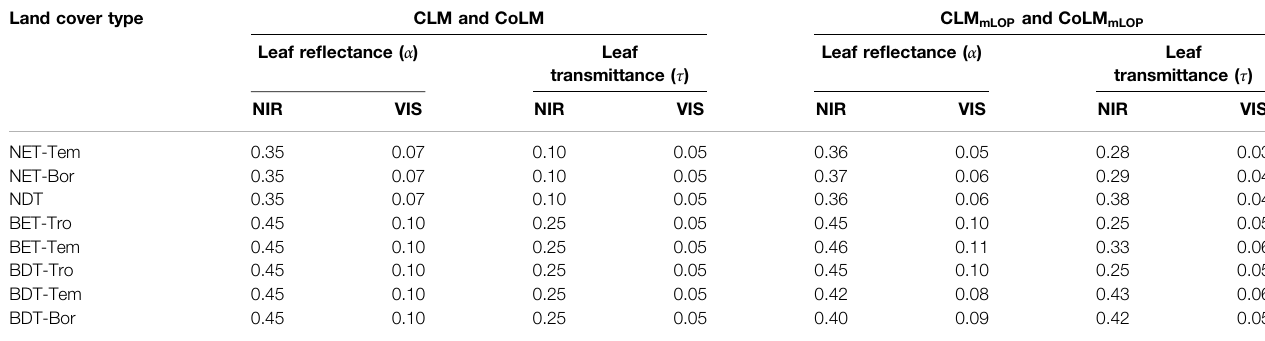
TABLE 1 | Default prescribed and measured leaf optical property values for each PFT set in CLM (CoLM) and CLM mLOP ( CoLM mLOP ). Land cover